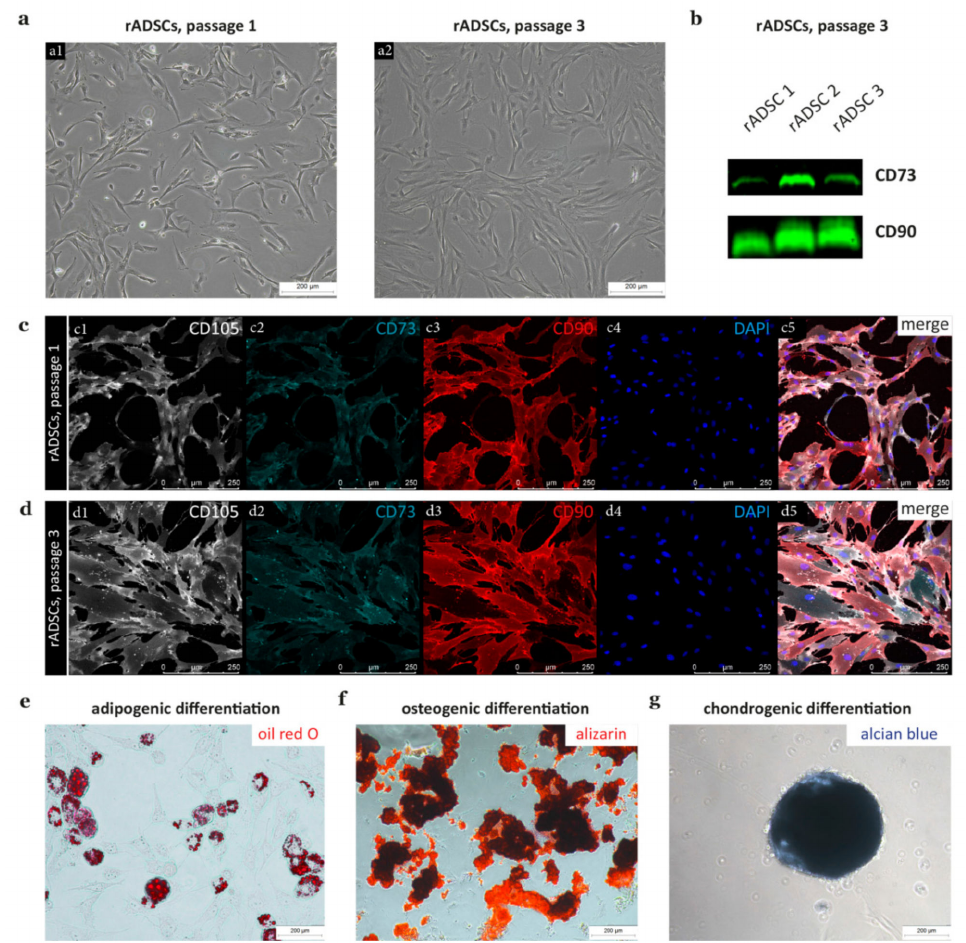
Figure 1. Characterization of rat adipose tissue derived stem cells (rADSCs). ( a ) Phase contrast images of rADSCs in p1 ( a1 ) and p3 ( a2 ). ( b ) Western blot results for three rADSC donors double